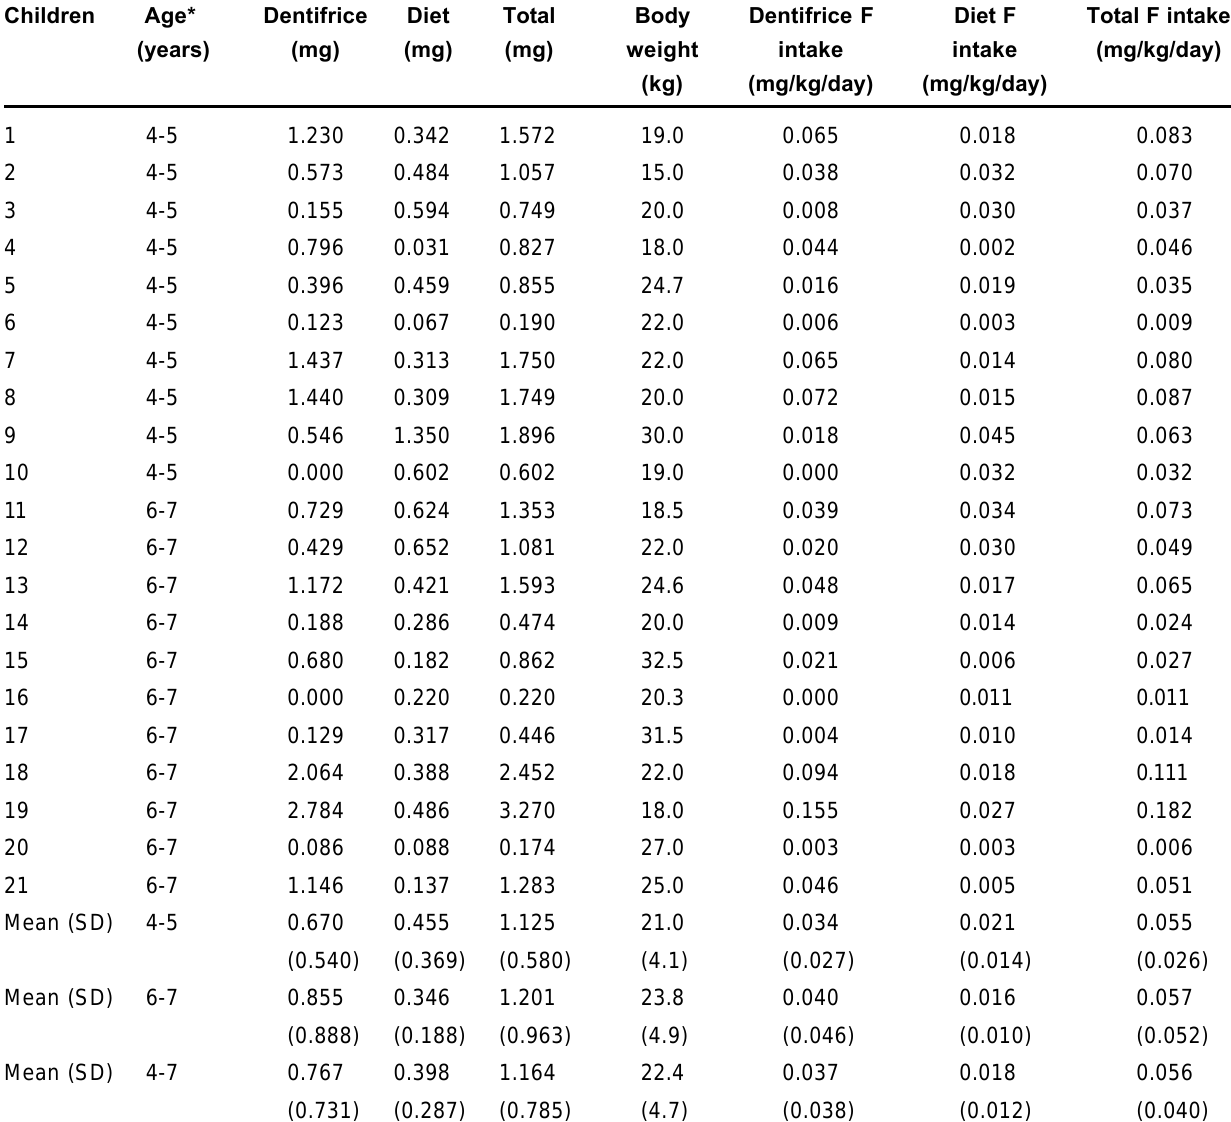
* Groups A and B are constituted by children aging 4-5 and 6-7- year-old children, respectively.